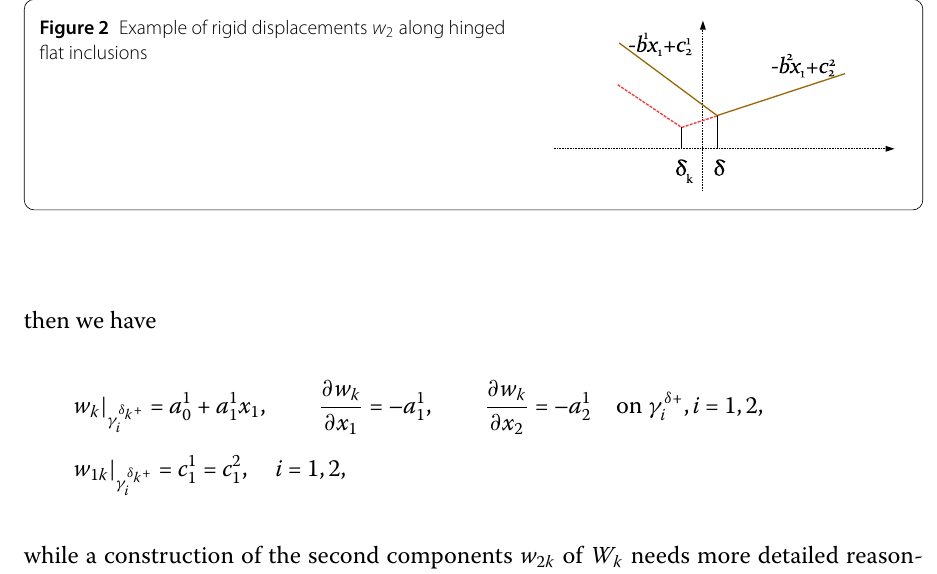
Figure 2 Example of rigid displacements w 2 along hinged flat